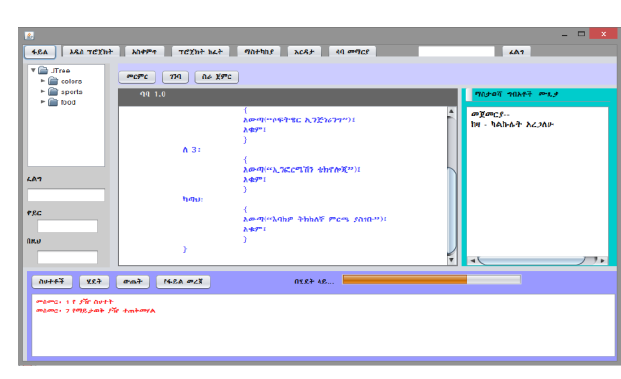
Figure 6. Compilation